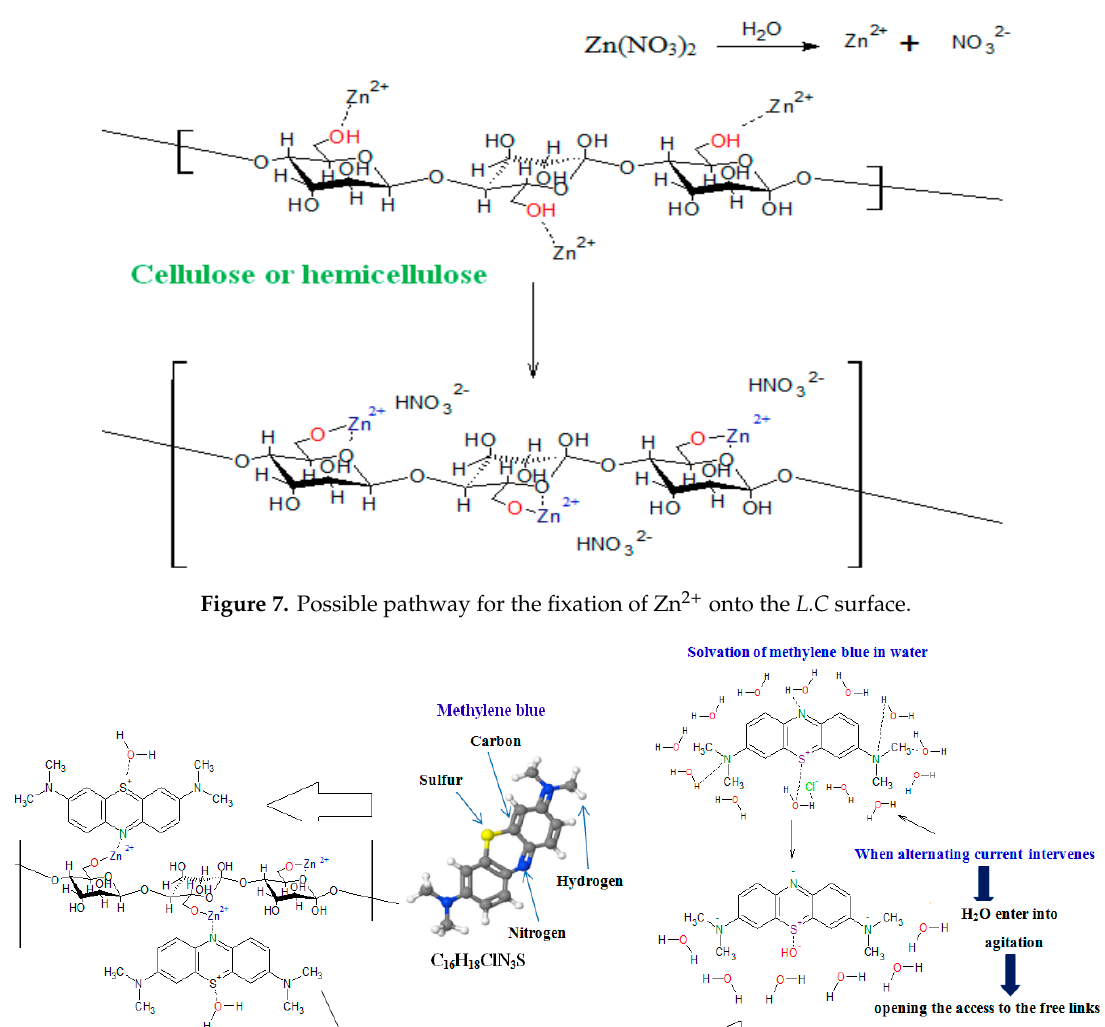
Figure 8. Possible pathway for the interactions between methylene blue and the synthesized hybrid material.